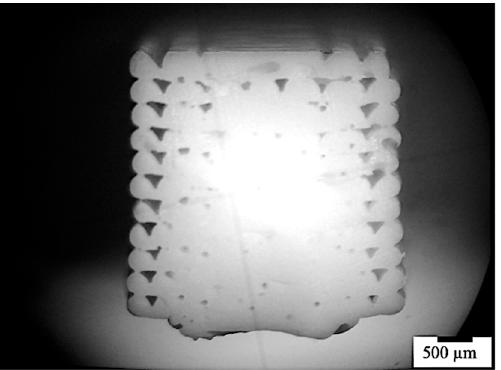
Figure 5. Optical micrograph of the specimen obtained with T n = 230 °C and T b = 90 °C. The bottom part corresponds to the layer which contacts the deposition plate.